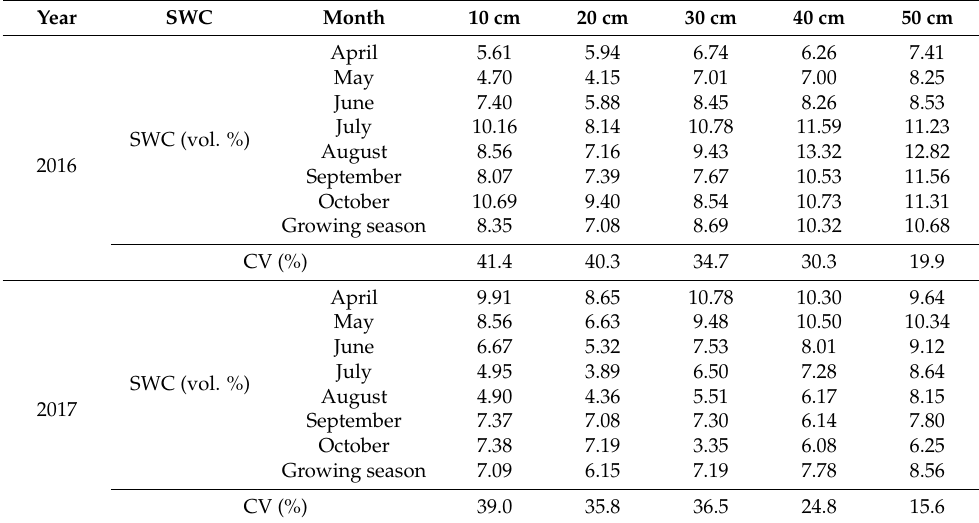
Table 3. SWC at 10–50 cm for each month during the growing season in different precipitation years.